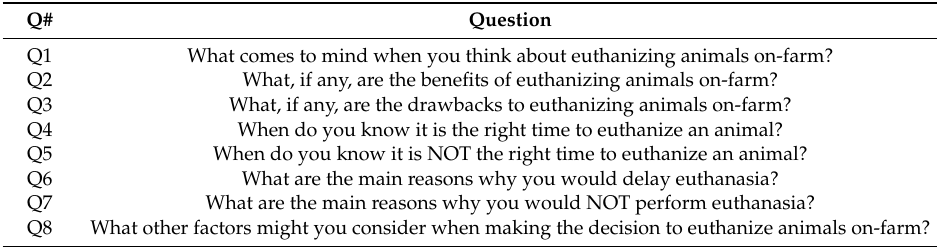
Table 1. Questions utilized in a focus group discussion on timely euthanasia on dairy farms in the